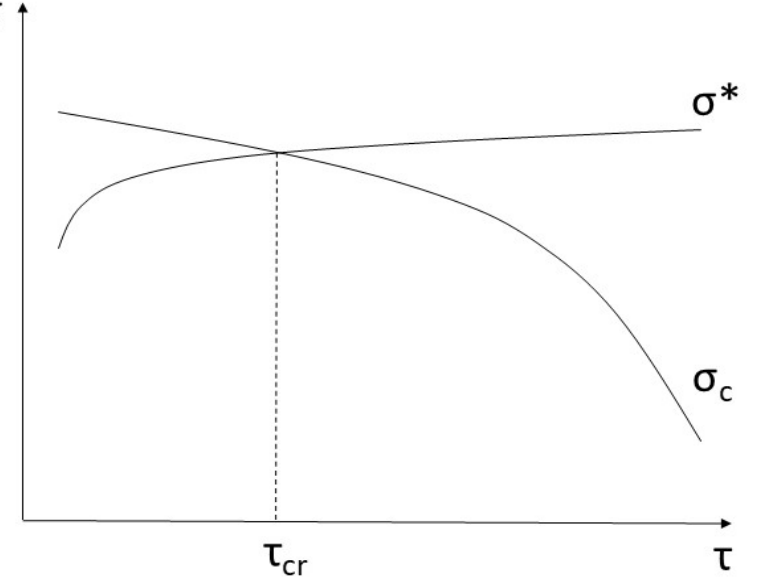
Figure 8. Schematic representation of the dependence of the composite strength σ on the shear strength of the interface between the matrix and the fiber τ.